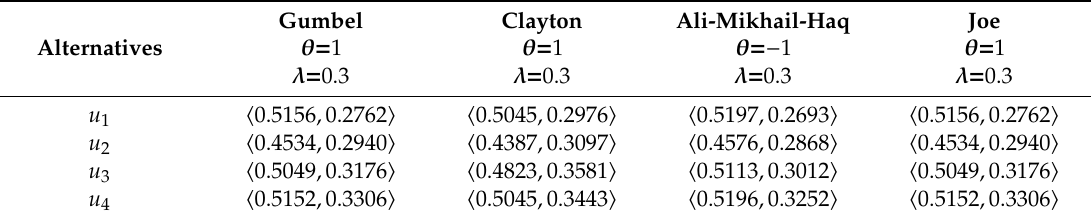
Table 7. The aggregation results using intuitionistic fuzzy Archimedean copula weighted geometric aggregation ( IFACWGA w )